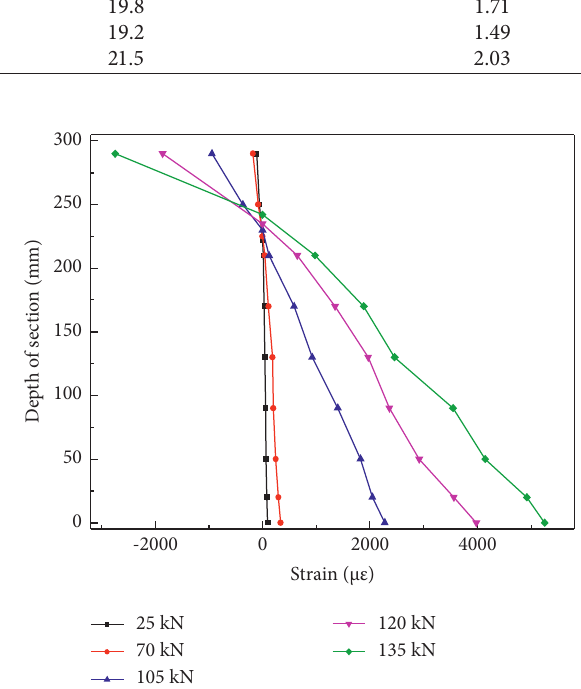
Figure 11: Average strain distribution across the medium section.